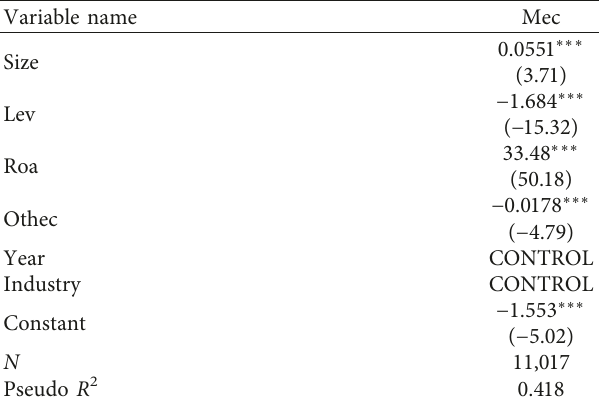
Table 6: The results of Heckman’s stage 1